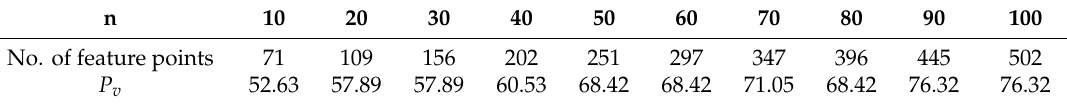
Table 6. Results of selecting features by percentage.